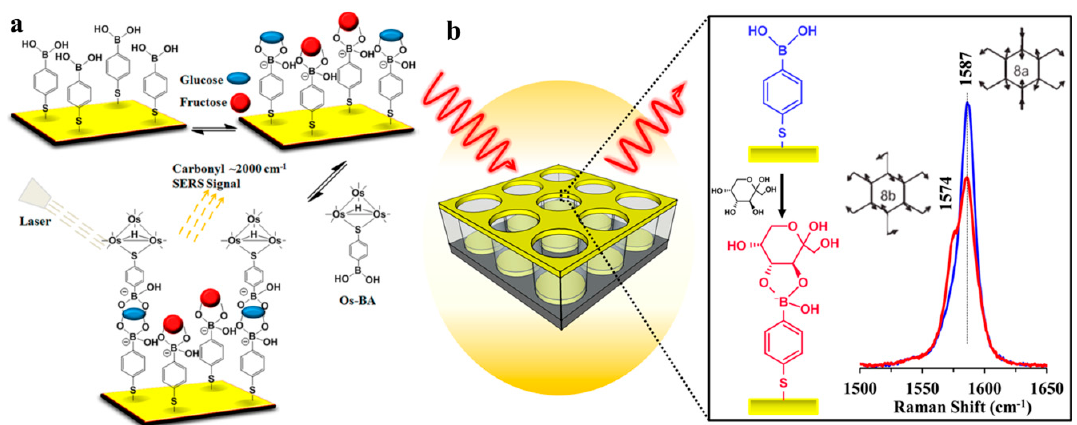
Figure 4. A glucose molecule brings Os-BA to the substrate via formation of a bidentate complex ( a ); Schematic illustration of 4-MPBA on a gold Q3D-PNA for the detection of fructose using SERS ( b ). Reproduced from ref. [211,213], with permission from American Chemical Society, 2013 and 2014,